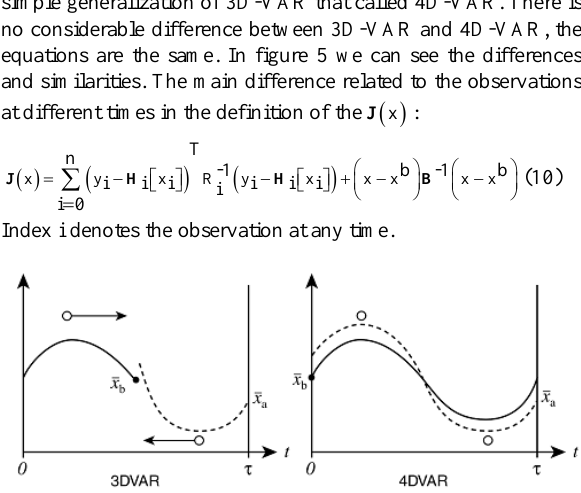
Figure 5. The comparison between 3D-VAR and 4D-VAR. Figure from [Holm, 2003]